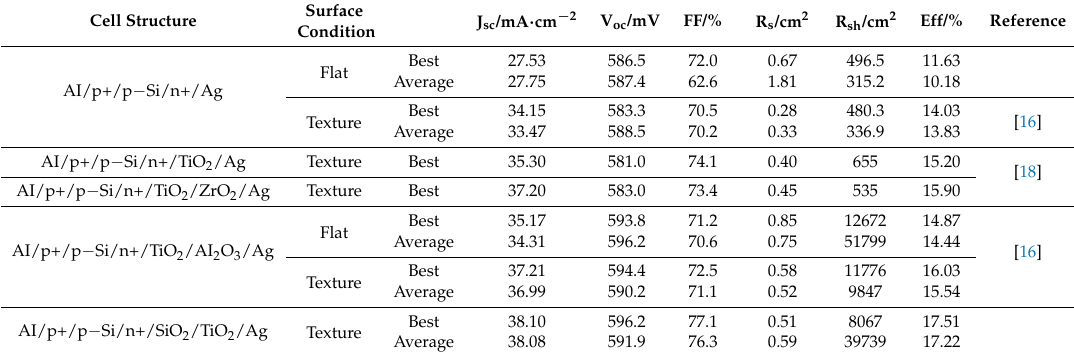
Table 1. Electrical characteristics of vacuum-less processed crystalline silicon solar cells. A summary including our previous